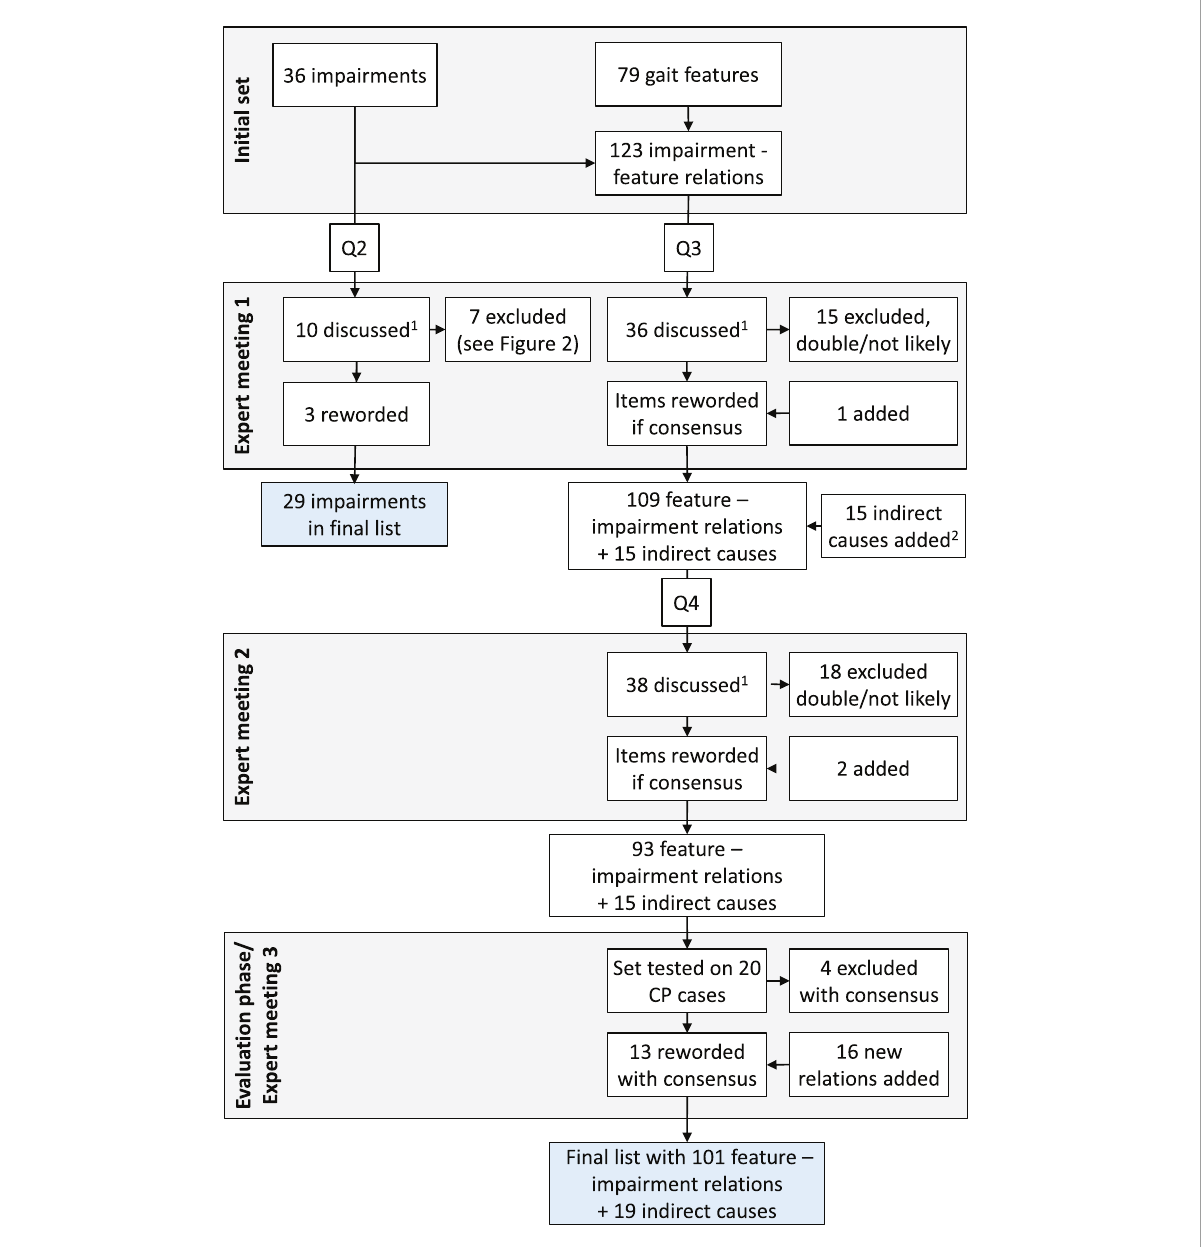
FIGURE1 Flow chart of the process of questionnaires (Q2-4) and expert meetings. Q1 is not included, as this questionnaire only asked for background and expertise of the panelists. 1 All items with low likelihood scores ( < 2, likely not relevant), a large difference between panelists (range > 3, possibly unclear), or that received many comments were discussed. 2 In the list of gait deviations with potential underlying causes, several “indirect causes” were also added, such as secondary effects or compensations (see Supplementary Appendix A